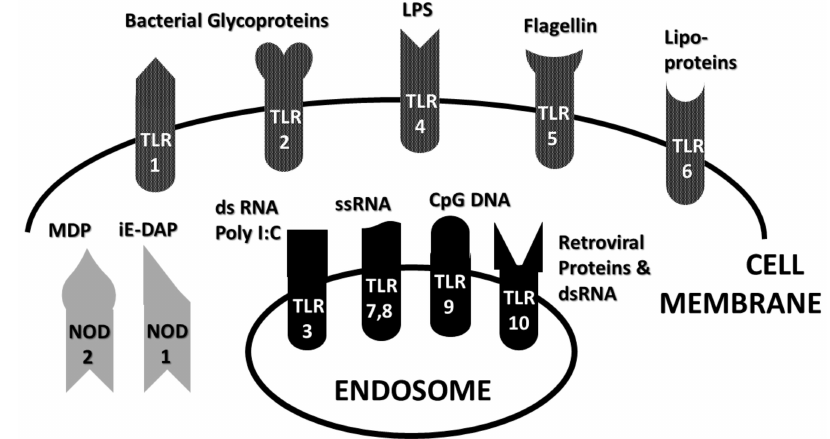
Figure 1. Schematic diagram summarizing the toll-like receptors (TLR) and nucleotide-binding oligomerization domain-containing proteins (NOD) locations (cell membrane, cytoplasm or endosome) on human innate immune system cells and their main activating ligands. MDP— N -acetyl- muramyl-D-alanyl-isoglutamine-containing peptides; iE-DAP— γ -D-glu-meso-diaminopimelic acid